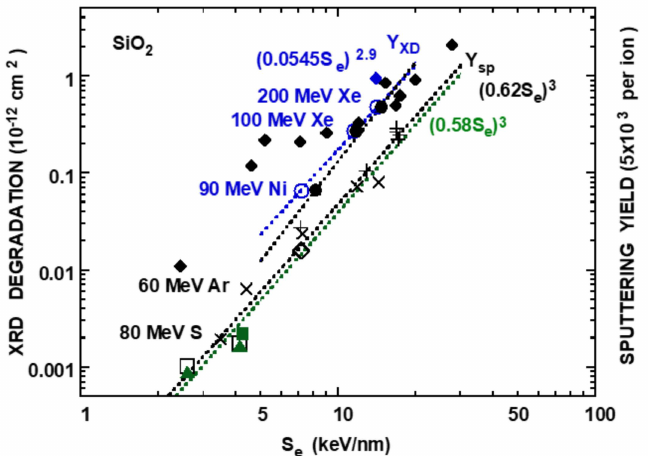
Figure 2. XRD degradation per unit fluence Y XD of polycrystalline SiO 2 film (o, present result) and sputtering yield Ysp (x) of amorphous (or vitreous)-SiO 2 ( (cid:3) , x)) and film of SiO 2 ( (cid:78) , (cid:4) , x, ♦ , +) as a function of electronic stopping power (S e ). Data ( (cid:3) , (cid:78) ) from (Qiu et al.) [45], ( (cid:4) ) from (Sugden et al.) [46], (x) from (Matsnami et al.) [47,48], ( ♦ ) from (Arnoldbik et al.) [49] and (+) from (Toulemonde et al.) [51]. S e is calculated using SRIM2013, and power-law fits of Y XD ((0.0545S e ) 2.9 ) and Y sp ((0.62S e ) 3.0 ) are indicated by blue and black dotted lines, respectively. Power-law fit ( • ) Y XD ((0.055S e ) 3.4 , TRIM1997) and Y sp ((0.58S e ) 3.0 , TRIM1985 through SRIM2010) from [47,48,51] are indicated by black and green dashed lines. Damage cross sections ( (cid:7) ) are obtained by RBS-C and ( (cid:7) ) by TEM from